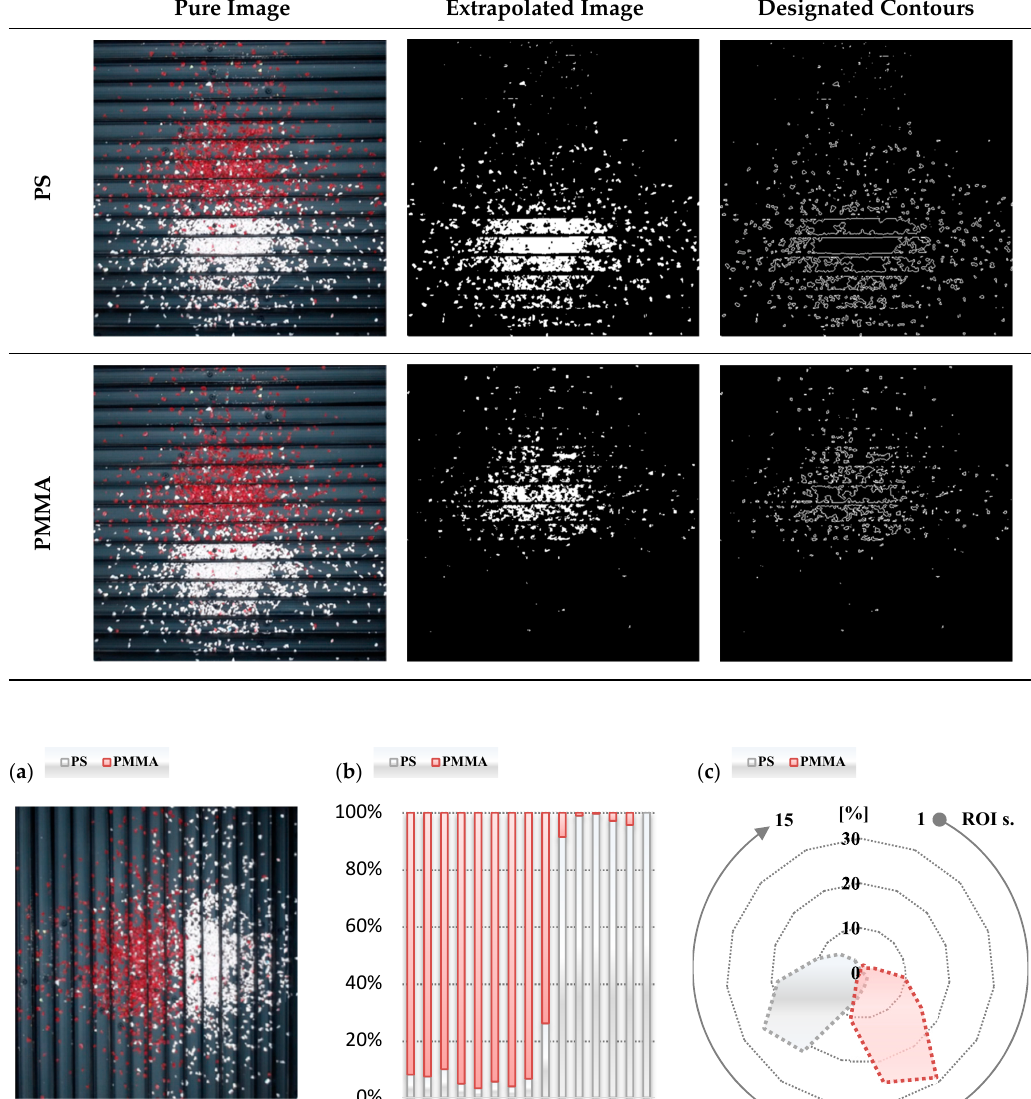
Table 4. Tests with separator—tribocharging mode.